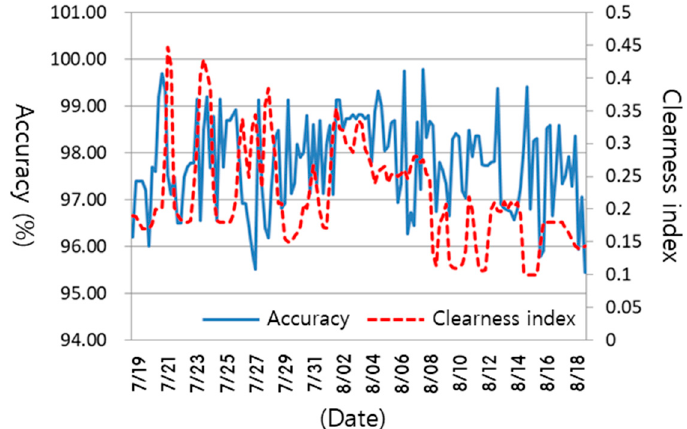
Figure 15. Variations of the target illuminance accuracy and clearness index.